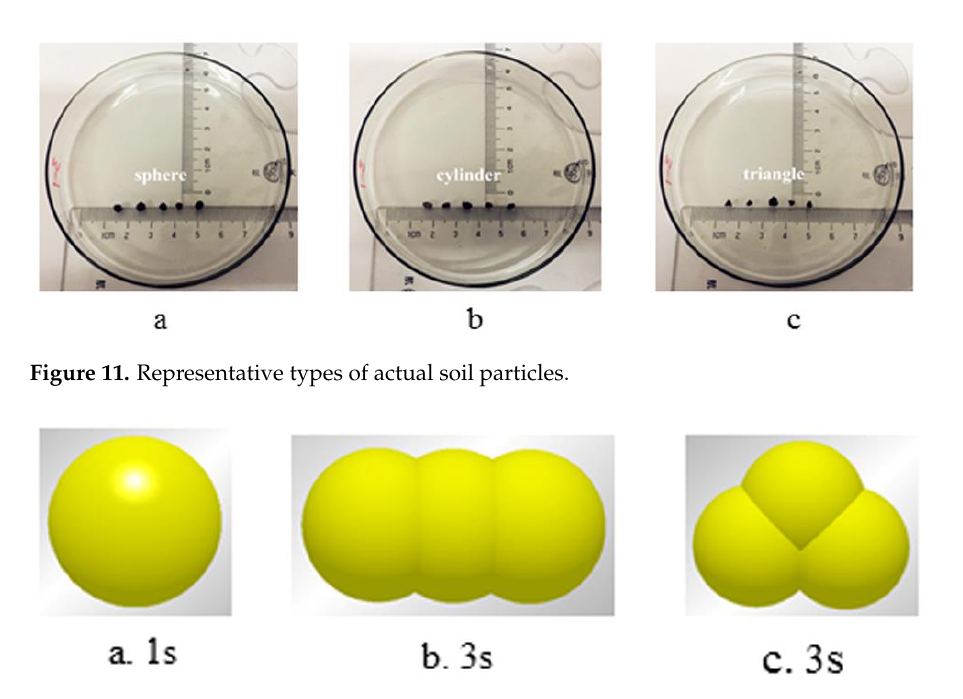
Figure 12. The soil particle models with different filling spheres (1-sphere, 3-sphere, 3-sphere models) in simulation.